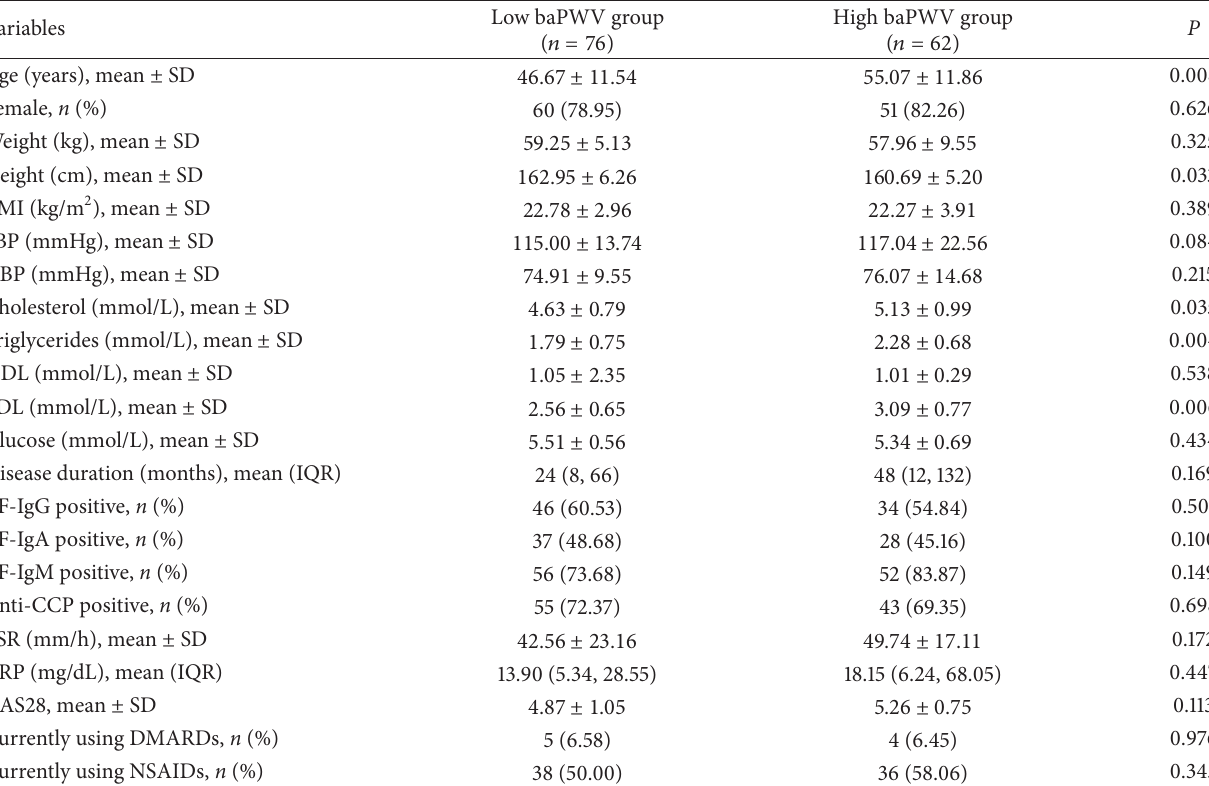
Table 3: Demographic and clinical characteristics of RA patients and comparisons between subgroups.